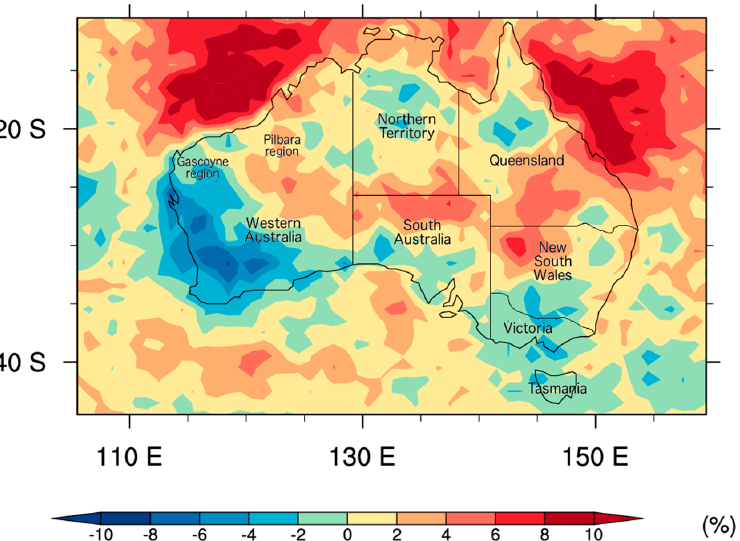
Figure 3. Change in average HIRS total cloud frequency % between two different eight-year periods for the Australian (10° S – 45° S, 105° E – 160° E) region. Difference = (1994 – 2001) minus (1985 – 1992). Table 3 examines the observational frequencies of total cloud as well as the frequency 257 of high clouds for the Australian region. Summaries are detailed for three different subsets 258 of data; the entire 17-year archive, El Niño years and La Niña years. Over the entire 17- 259 year archive, cloud of any type is observed 58% of the time over the Australian continent.